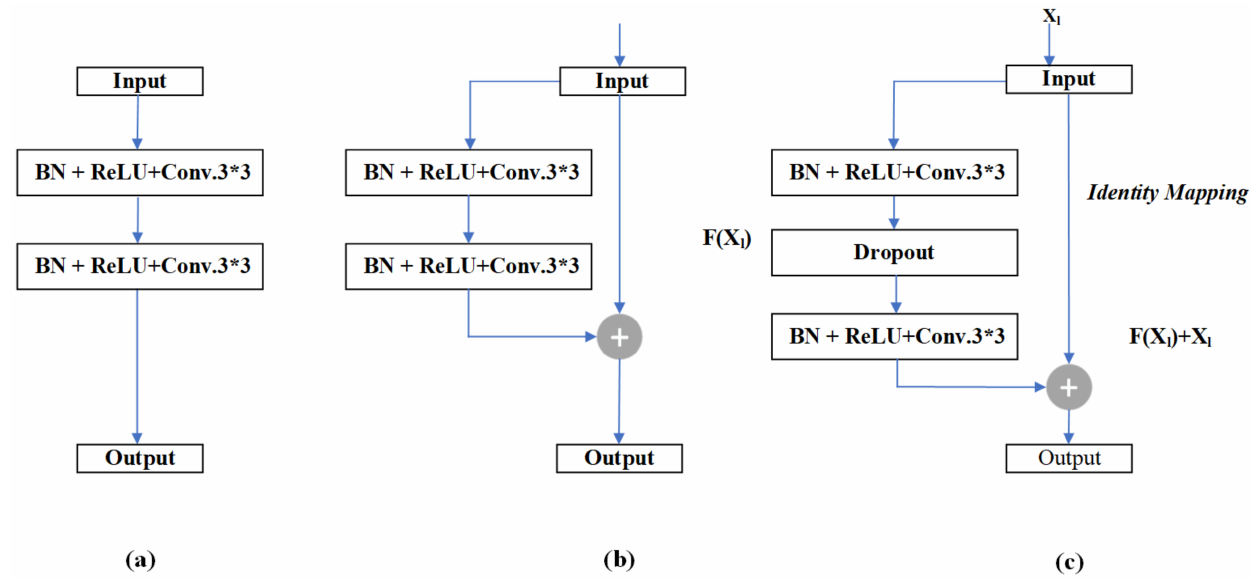
Figure 2. Different variants of convolutional and residual units. ( a ) Plain convolution units, ( b ) resid- ual unit, ( c ) residual unit with dropout layer.